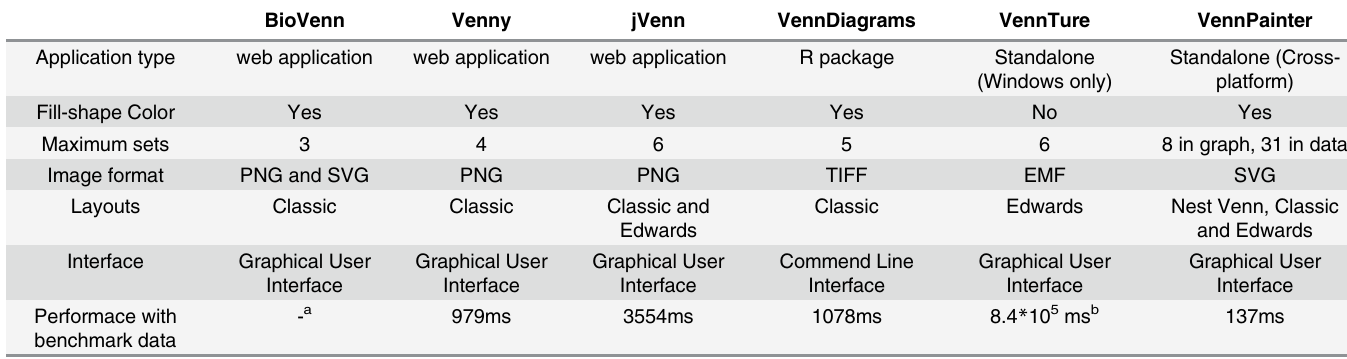
Table 1. Comparison of BioVenn, Venny, jVenn, VennDiagrams, VennTure, and